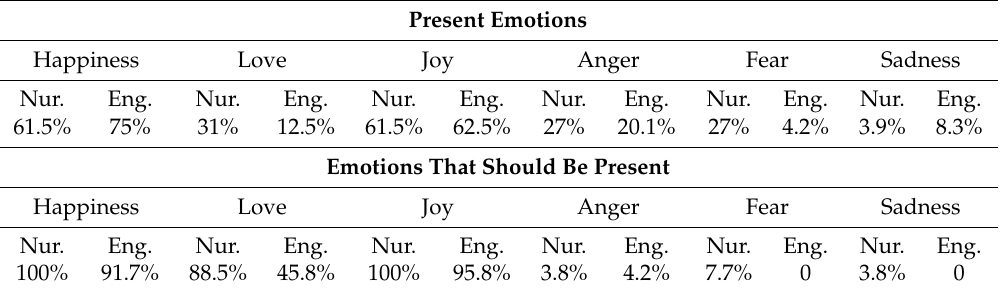
Table 4. Emotions